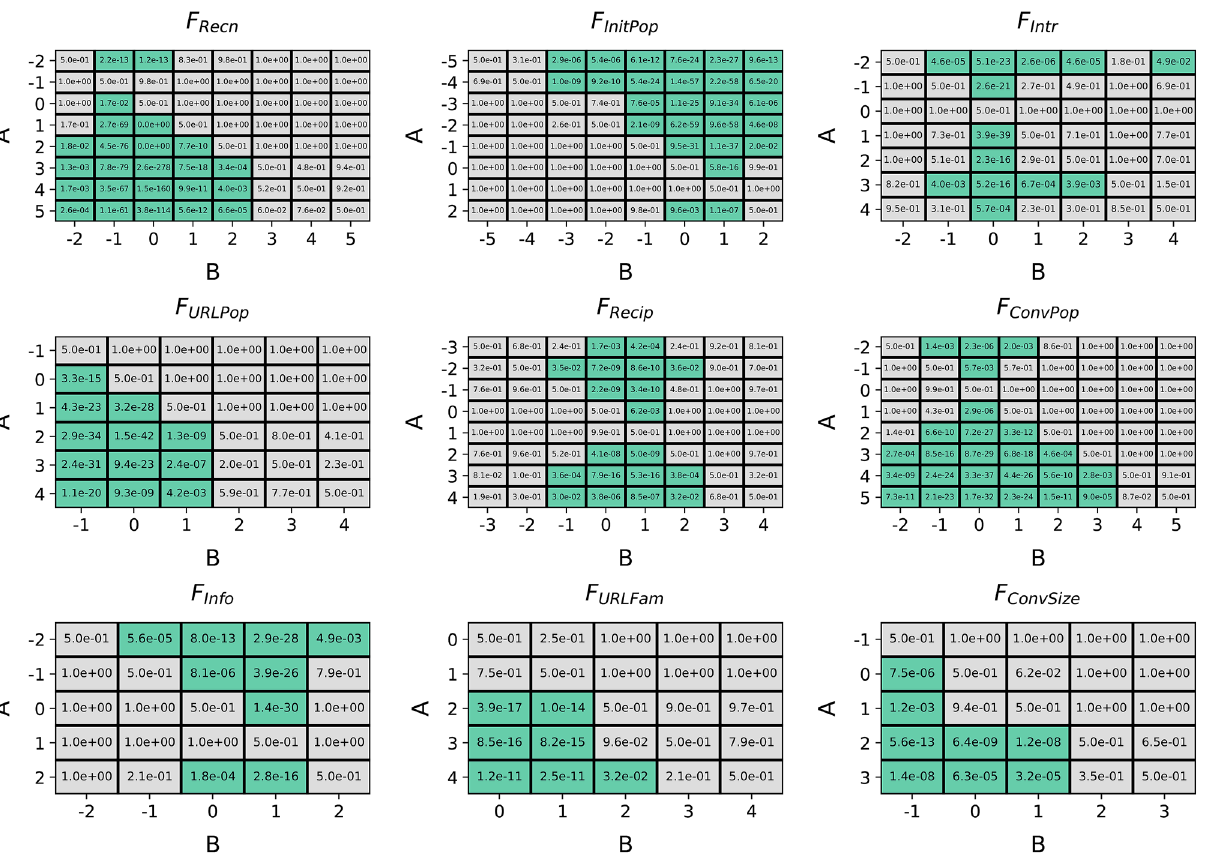
Figure 5. Optimal presence scores for hypothesized causal factors. P values of systematic one-tailed Mann– Whitney U tests between presence values of the nine hypothesized factors for the alternate hypothesis: RMSE for presence A < RMSE for presence B (null hypothesis: RMSE for presence A = RMSE for presence B ) for original significance level = 0.05 with Bonferroni corrections applied for all comparisons within each factor. Green cells indicate agreement of the alternate hypothesis. F Recn , F ConvPop , F ConvSize , F URLPop , F URLFam , and F Recip are optimal at positive presence within u ( m ), while F InitPop and F Info are optimal when present negatively within u ( m ). F Intr is optimal at both negative and positive presence